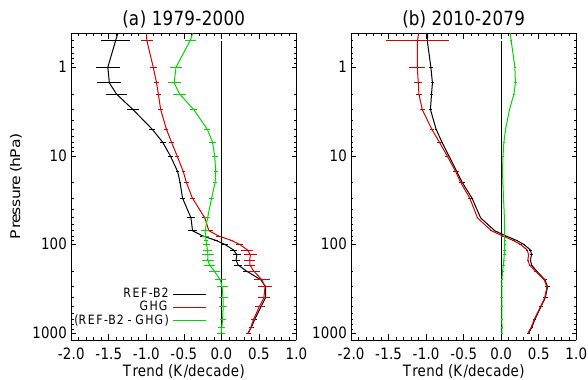
Fig. 1. Linear trends in global annual average temperature over the periods 1979–2000 (a) and 2010–2079 (b) . Trends were calculated from ensemble averages of the REF-B2 (black line) and GHG runs (red line). The trend attributed to ODSs, derived as (REF-B2–GHG), is given by the green line. The 95% confidence intervals of the trends are given by the horizontal bars.